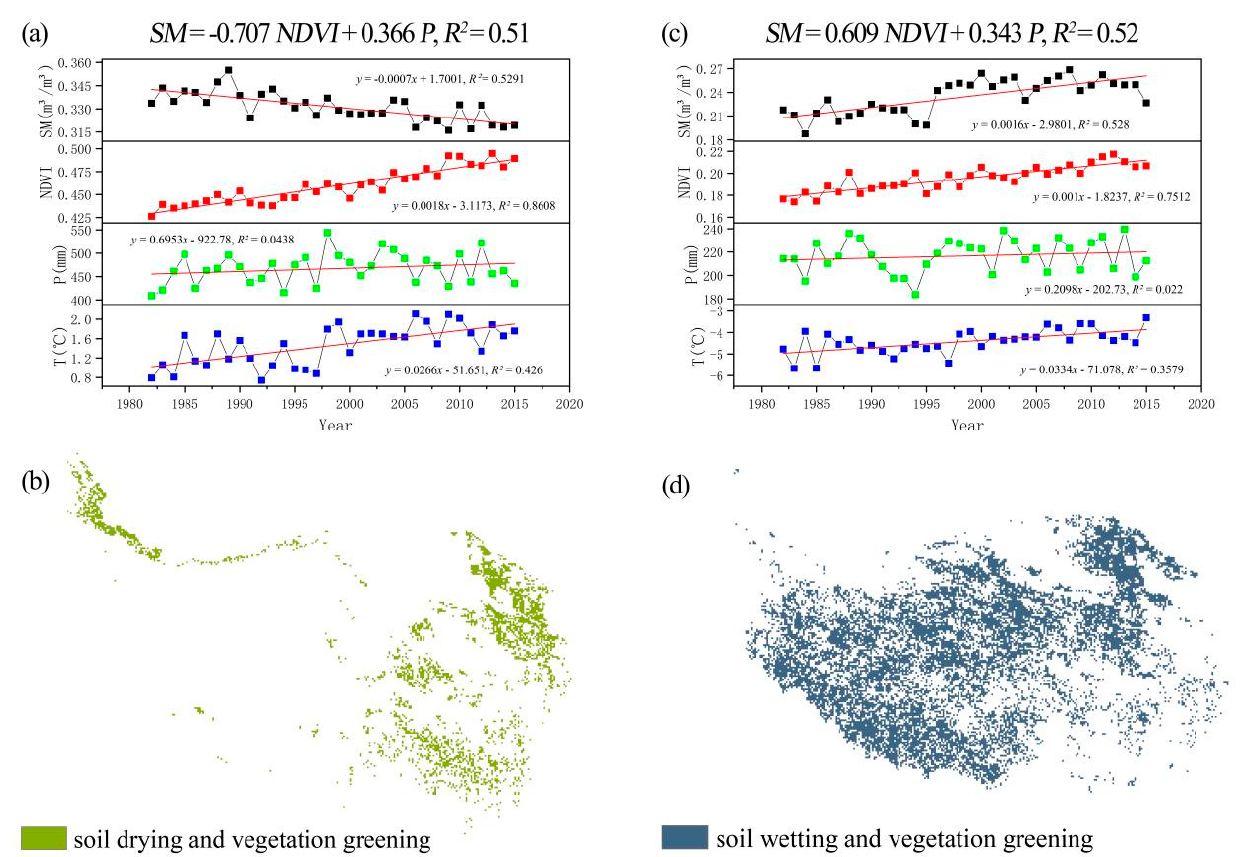
Figure 7. Changes in annual mean precipitation (P), temperature (T), NDVI, and SM in the ( a ) soil drying and ( c ) soil wetting zones from 1982 to 2015. The stepwise regression equation for SM is shown at the top of Figure 7. ( b , d ) are the spatial distribution of soil drying and soil wetting zones, respectively.